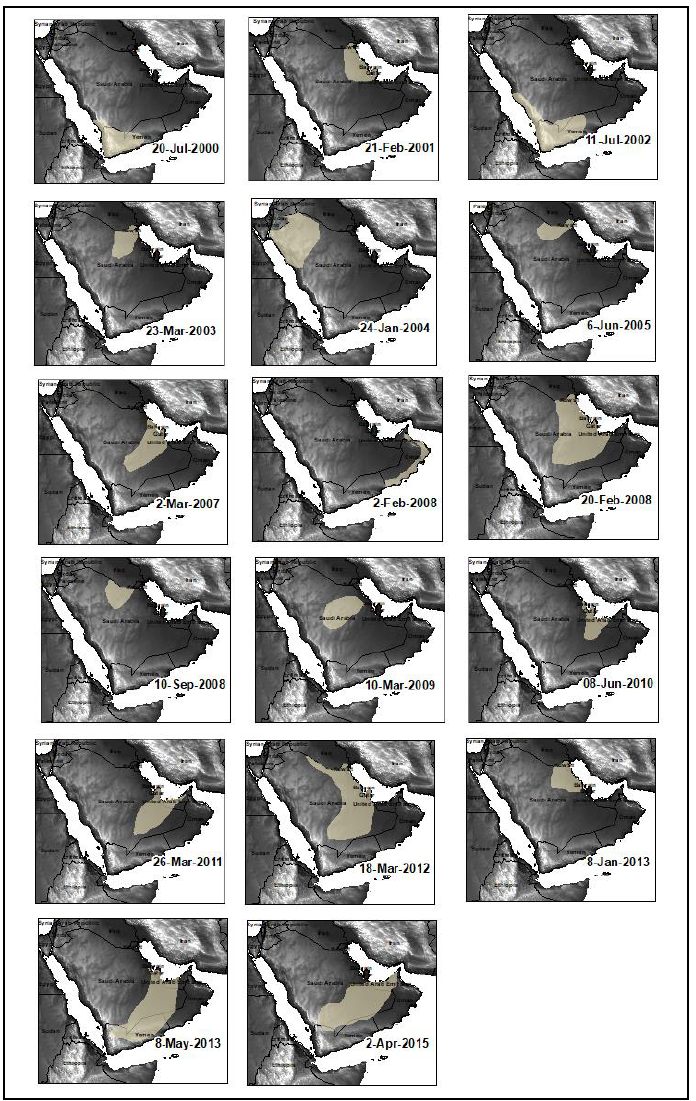
Figure 2. The extent of the 17 dust storms over the Arabian Peninsula as indicated by light yellow-colored polygons with a topographic map (grey scaled) as background.